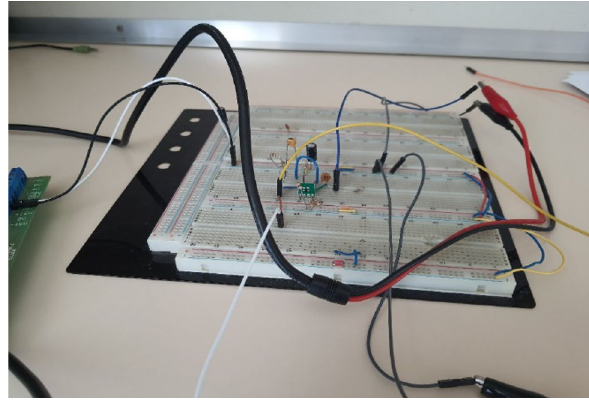
Fig. 6 Gain at 104 kHz, shown to be 4 V/V, as designed